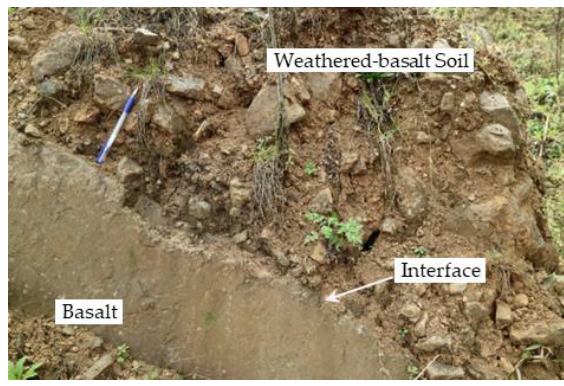
Figure 10. Interfaces of the soil and rock layers.